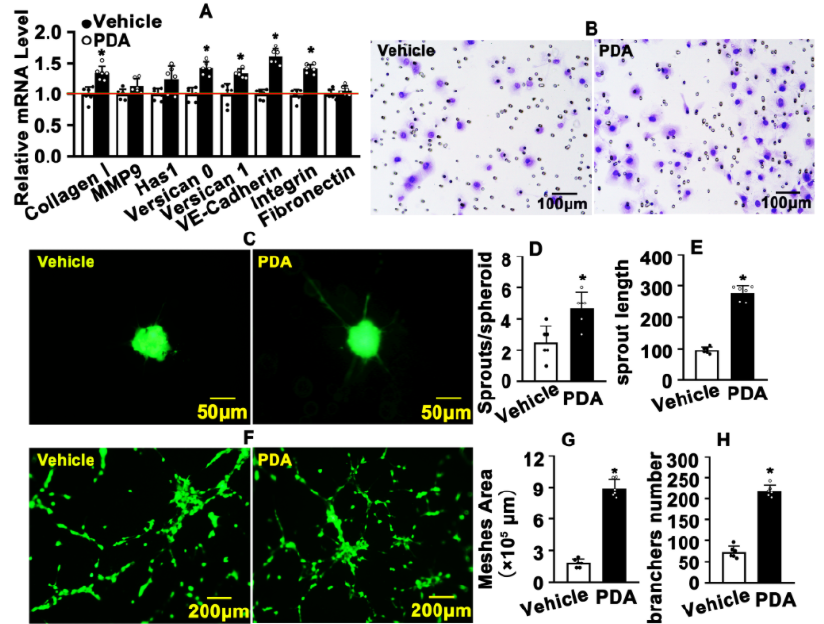
Figure 3. PDA promotes vascular endothelial cell migration. ( A ) HUVEC-Cs were treated with PDA (10 µ M) for 24 h and real-time PCR was performed to evaluate transcription levels of migrative-related genes ( n = 6). ( B ) The Boyden chamber cell migration assay was performed following PDA (10 µ M, 24 h) treatment, and the migrated cells were visualized with crystal violet staining. ( C ) A spheroid sprouting assay was performed in the presence of PDA (10 µ M, 24 h), and the sprouting of HUVEC-Cs was visualized using calcein AM staining. Quantification of sprouts and total sprout lengths are exhibited in ( D , E ) ( n = 6). ( F ) The Matrigel-based tube formation assay was performed after PDA (10 µ M) treatment for 48 h. The branch numbers and mesh areas are quantified in ( G , H ) ( n = 6). The analysis data are expressed as means ± SEM. * p < 0.05.